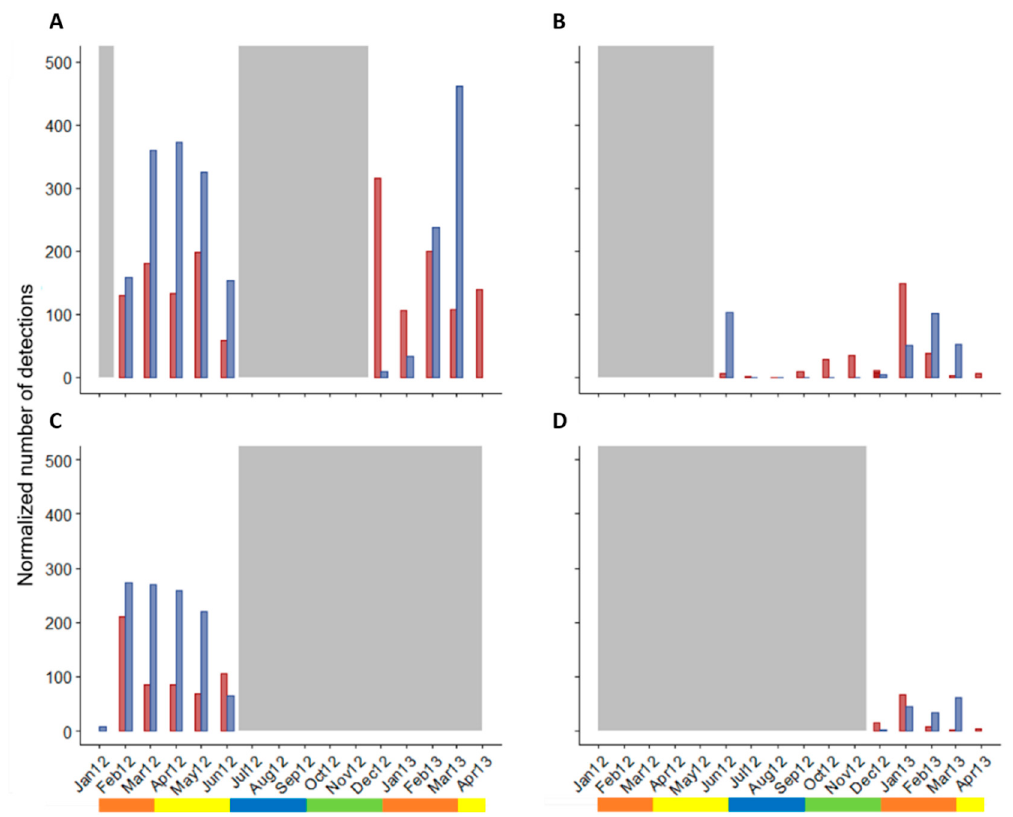
Figure 5. Normalized number of monthly D (red) and SEP (blue) call detections for each site: Guafo North ( A ), Melimoyu ( B ), Northwest Chiloe ( C ) and Tic Toc Bay ( D ). Periods shaded in grey indicate times when no data were collected. Colour bars represent seasons (orange: summer; yellow: fall; blue: winter; green: spring).